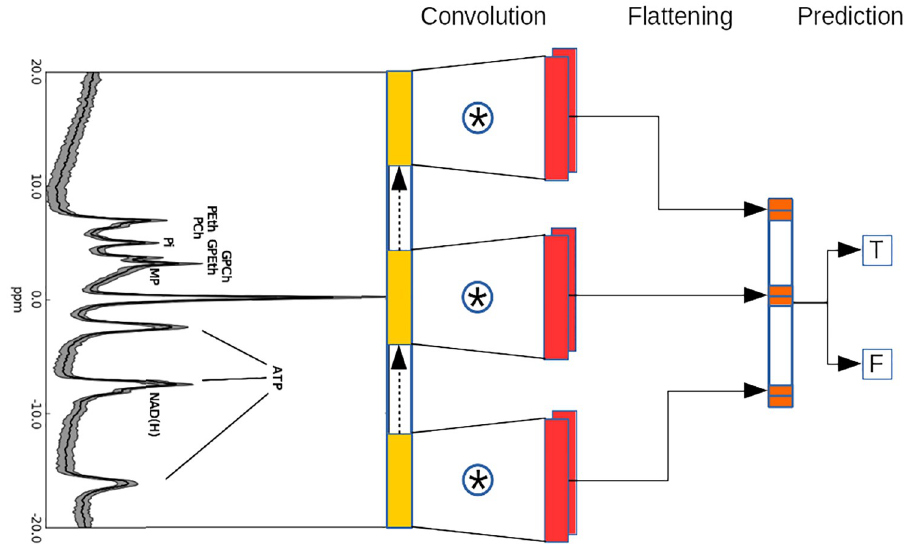
Fig 2. SL-CNN architecture and functioning for a 2 classes classification task (T or F to separate Alzheimer’s disease and normals). The convolution is performed by sliding each kernel of the convolutional layer over the input spectrum of the dataset. At every location (yellow), a vector multiplication is performed and sums the result onto the feature map (orange). Then, the output of the convolutional layer is reshaped into a vector (flattening) and used for prediction (T or F). In this example, 2 kernels (red) are